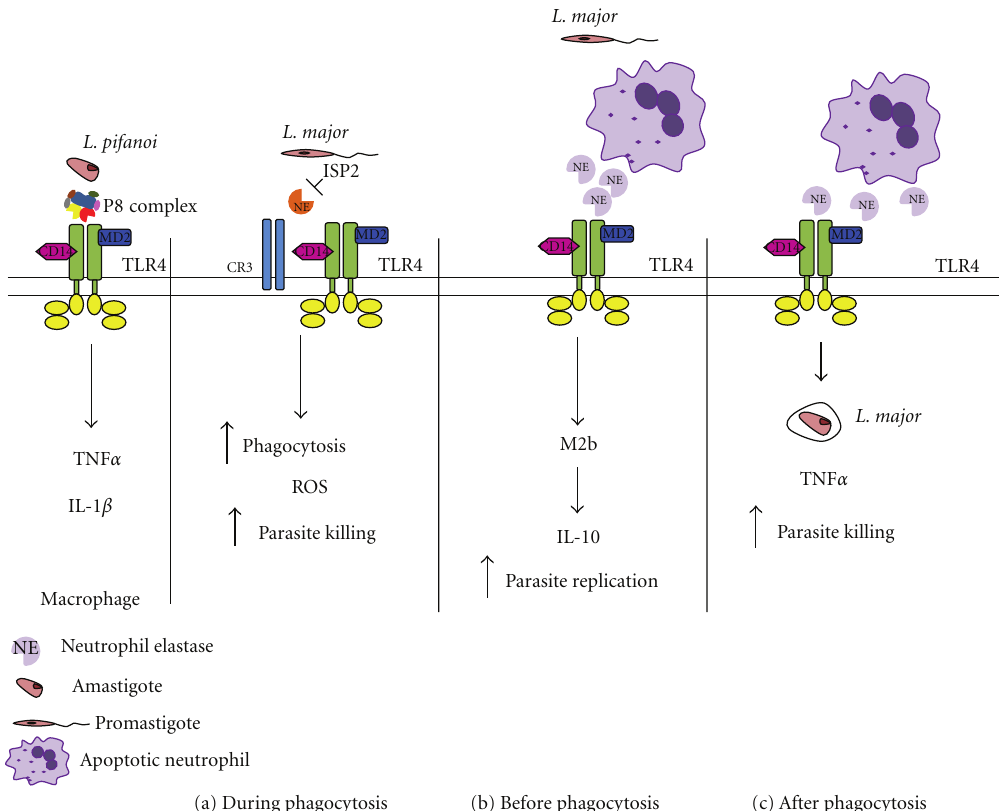
Figure 2: Model for the activation of TLR4 in di ff erent settings of Leishmania infections. L. pifanoi amastigote-derived P8 glycolipid complex stimulates TLR4 in macrophages in an MD2, CD14, and MyD88-dependent manner, leading to the production of proinflammatory cytokines (left panel) [46]. Microenvironments during the activation of TLR4 in macrophages of C57BL6 mice by neutrophil elastase (NE): in (a), during the phagocytosis of L. major promastigotes, CR3, TLR4, and NE at the surface of macrophages increase parasite uptake but lead to ROS production and to partial parasite elimination within 24h [47], the control of NE activity by parasite ISP2 prevents TLR4 activation and protects parasite from intracellular killing [47, 48]; in (b), macrophages remove apoptotic neutrophils by phagocytosis and acquire a M2b phenotype, leading to IL10 production and increased permissiveness to parasite growth; in (c), macrophages are infected by L. major and subsequently interact with apoptotic neutrophils, resulting in the activation of TLR4 by NE and in the production of TNF that promotes parasite